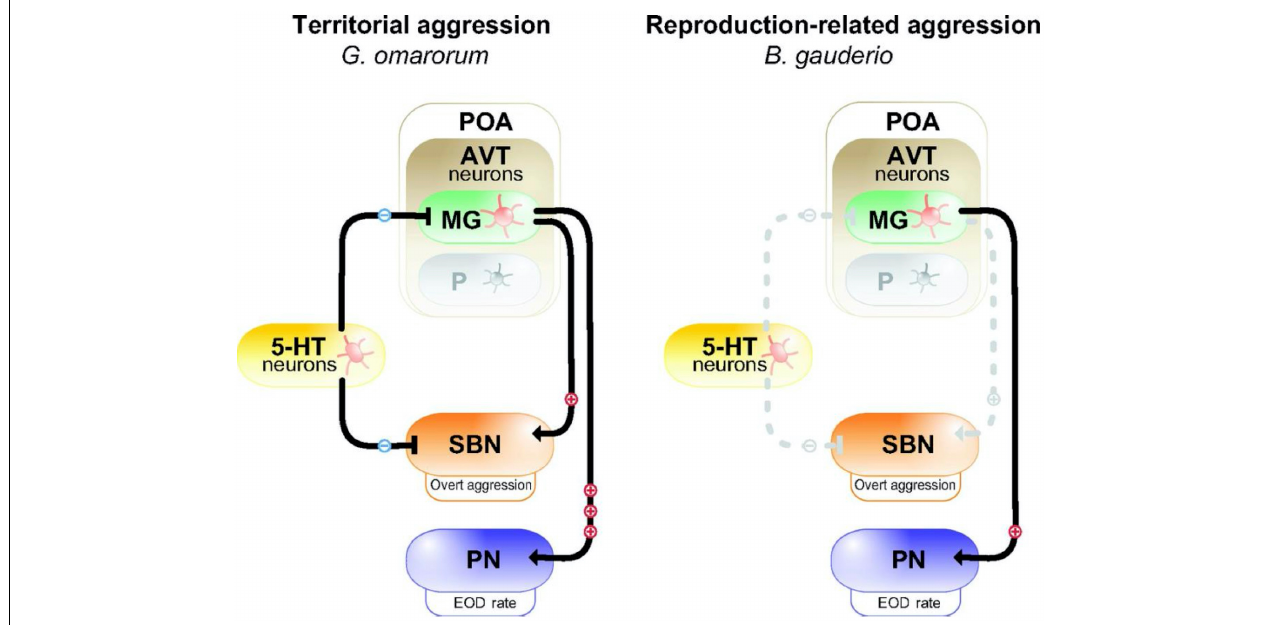
FIGURE 2 | Model for the neuromodulation of aggression by AVT and 5-HT in dominants of two species of electric fish with different forms of aggression. In dominant Gymnotus omarorum (left) , which displays territorial aggression year round, AVT magno-gigantocellular neurons (MG) in the pre-optic area (POA) strongly activate (+++) the pacemaker nucleus (PN) to increase EOD rate, and weakly active (+) overt aggression through the social behavioral network (SBN). 5-HT neurons inhibit ( − ) overt aggression. In dominant Brachyhypopomus gauderio (right) , which shows only reproduction-related aggression during the breeding season, AVT-containing MG cells of the POA weakly (+) increase EOD rate, but have no effect (dashed line) on overt aggression. 5-HT has no effect on aggression. The parvocellular cells (P) in the POA do not participate in regulating aggression in dominants of either species. Reproduced/adapted with permission from the Journal of Experimental Biology, Silva et al.